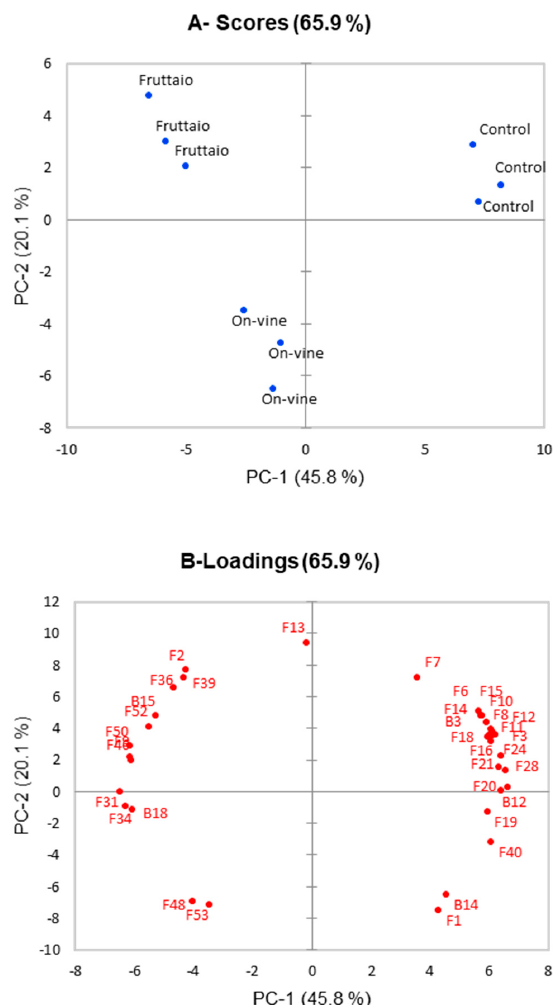
Figure 1. Principal component analysis showing aged wine samples scores ( A ) and loadings ( B ), only loadings with score value > 0.75 were shown. Loadings plot number correspond to: (F1) 2-Butanol, (F2) 1-Butanol, (F3) 1-Pentanol, (F6) 1-Hexanol, (F7) trans -3-Hexenol, (F8) cis -3-Hexenol, (F9) Ethyl acetate, (F10) Isoamyl acetate, (F11) n-Hexyl acetate, (F12) Phenylethyl acetate, (F13) Ethyl butanoate, (F14) Ethyl 3-methylbutanoate, (F15) Ethyl hexanoate, (F16) Ethyl octanoate, (F18) Ethyl lactate,